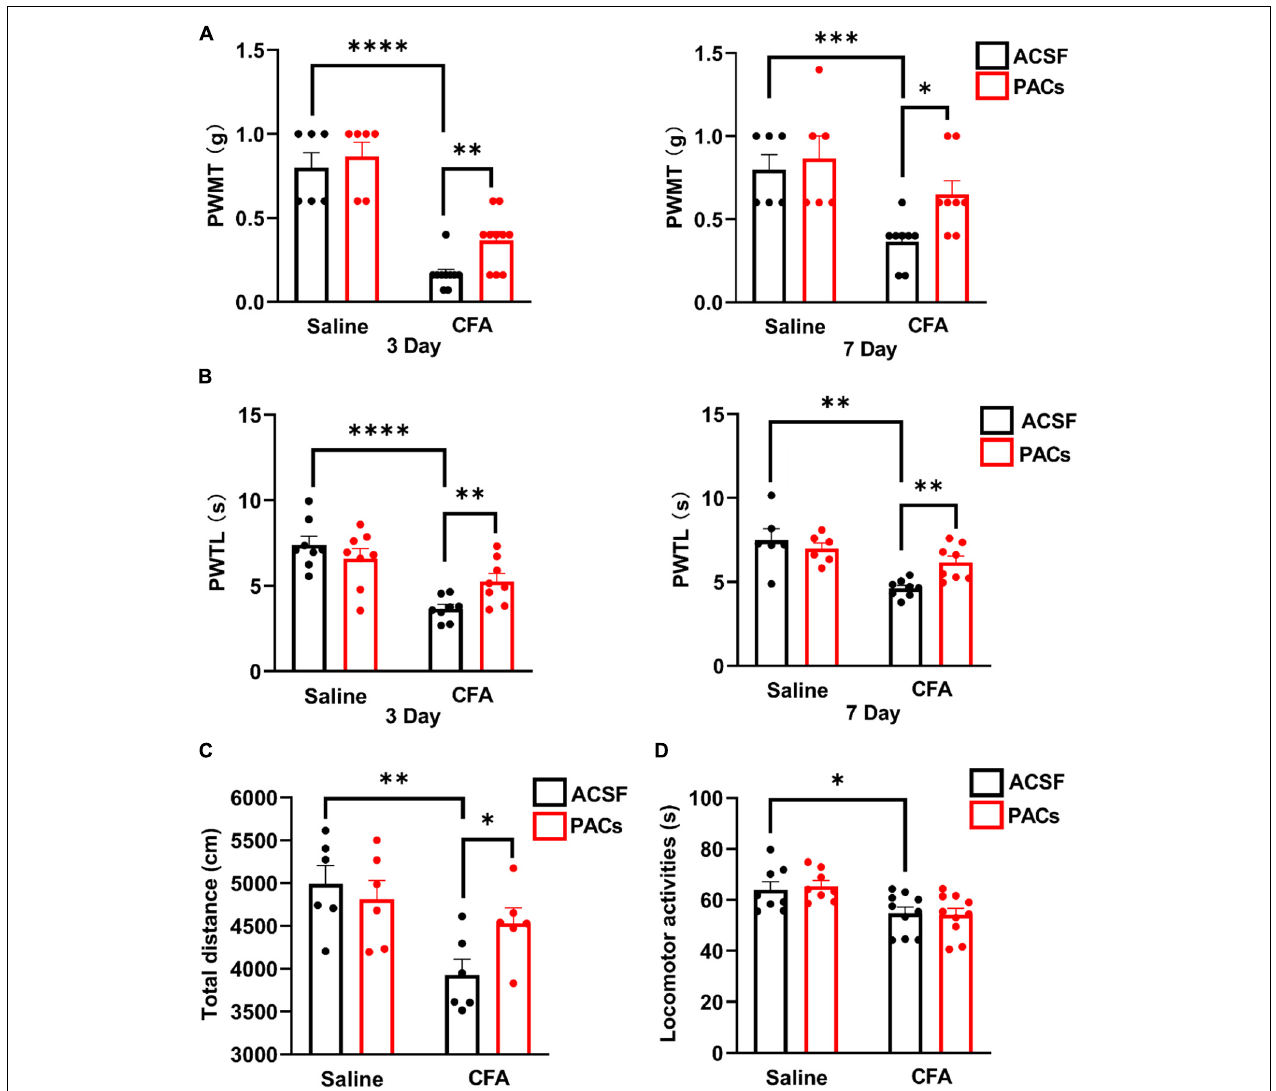
FIGURE 1 | Intrathecal injection of proanthocyanidins increased mechanical and thermal pain thresholds in mice with CFA injection. Intrathecal injection of proanthocyanidins on the third and seventh day post-surgery increased the paw withdrawal mechanical threshold (PWMT) (A) and paw withdrawal thermal latency (PWTL) (B) of mice in the CFA group. (C) Intrathecal injection of proanthocyanidins increased the movement distance of mice in the CFA group. (D) Intrathecal injection of proanthocyanidins had no effect on the motor function of mice in either the CFA or saline group in the rotary rod test. ∗ P < 0.05; ∗∗ P < 0.01; ∗∗∗ P < 0.001; ∗∗∗∗ P < 0.0001. PWMT, paw withdrawal mechanical threshold; PWTL, paw withdrawal thermal latency; CFA, Complete Freund’s Adjuvant; ACSF, artificial cerebrospinal fluid; PACs,